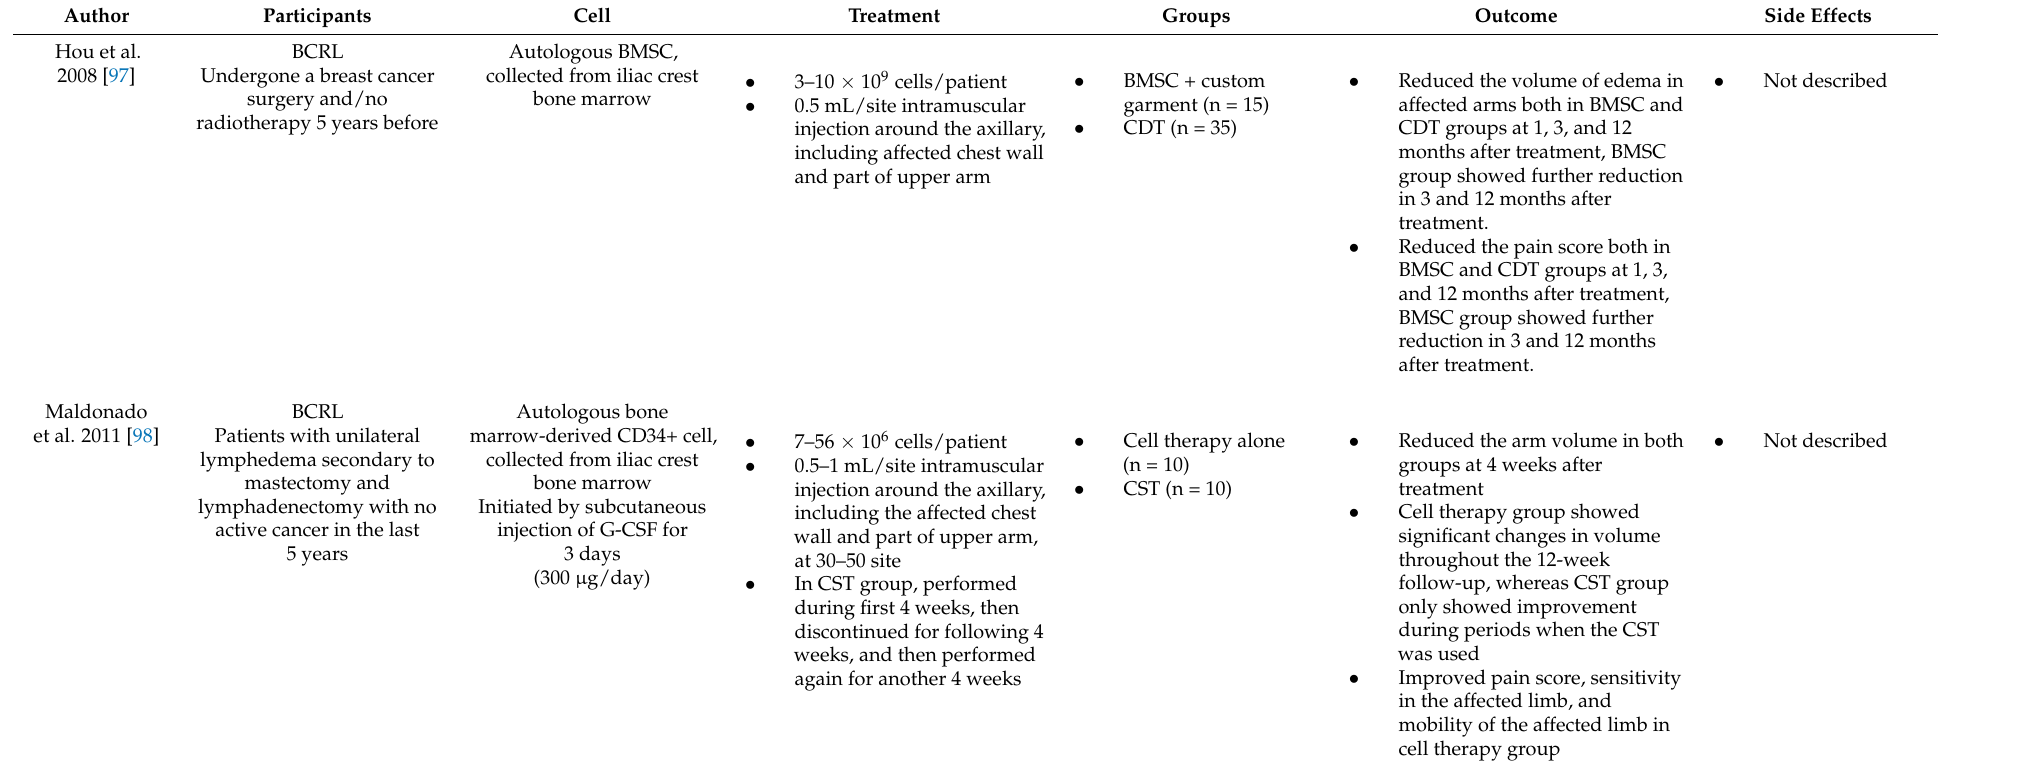
Table 2. Cell-based therapies in patients with